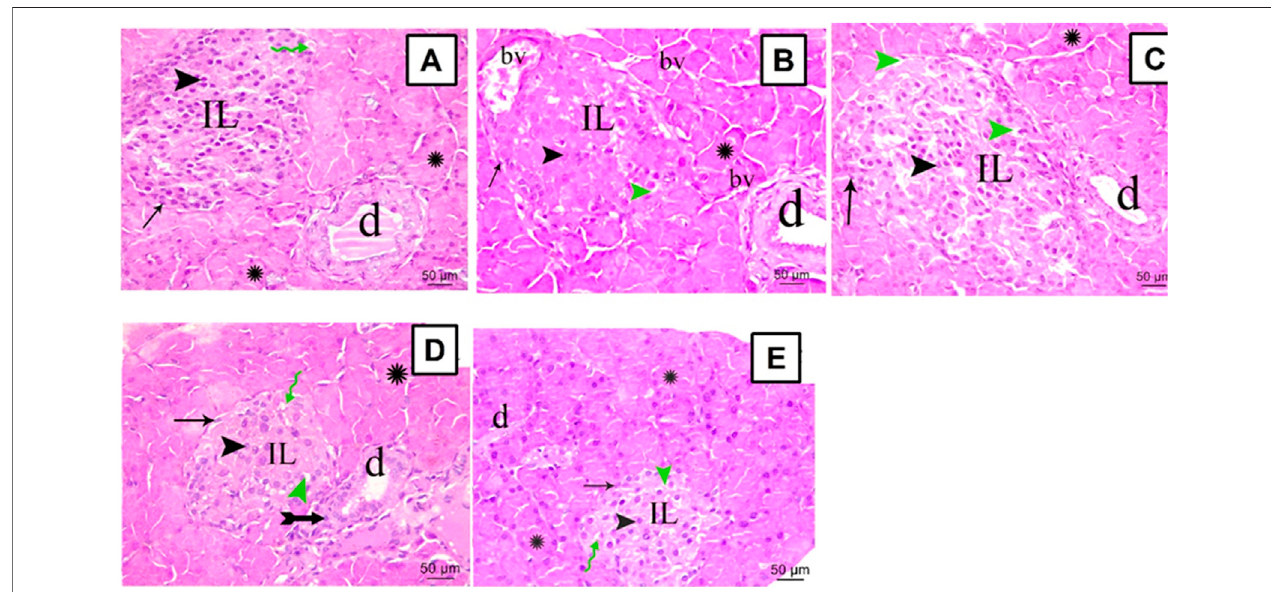
FIGURE 3 | Stained photomicrographs with H&E of pancreatic sections from normal rats (A) , STZ diabetic rats (B) , S. aqueum (SA) extract (100 mg/kg) (C) , S. aqueum (SA) extract (200 mg/kg) (D) , and the reference drug, glibenclamide (E) . Green Zigzag arrow, arrow, arrowhead, green arrowhead, asterisk, and tailed arrow represent blood capillary, α cells, β cells, areas of vacuolation, acini, and in fl ammatory cells. (IL) Langerhans islets (bv) blood vessels and (d) duct. H and E; scale bar: 50 μ m.